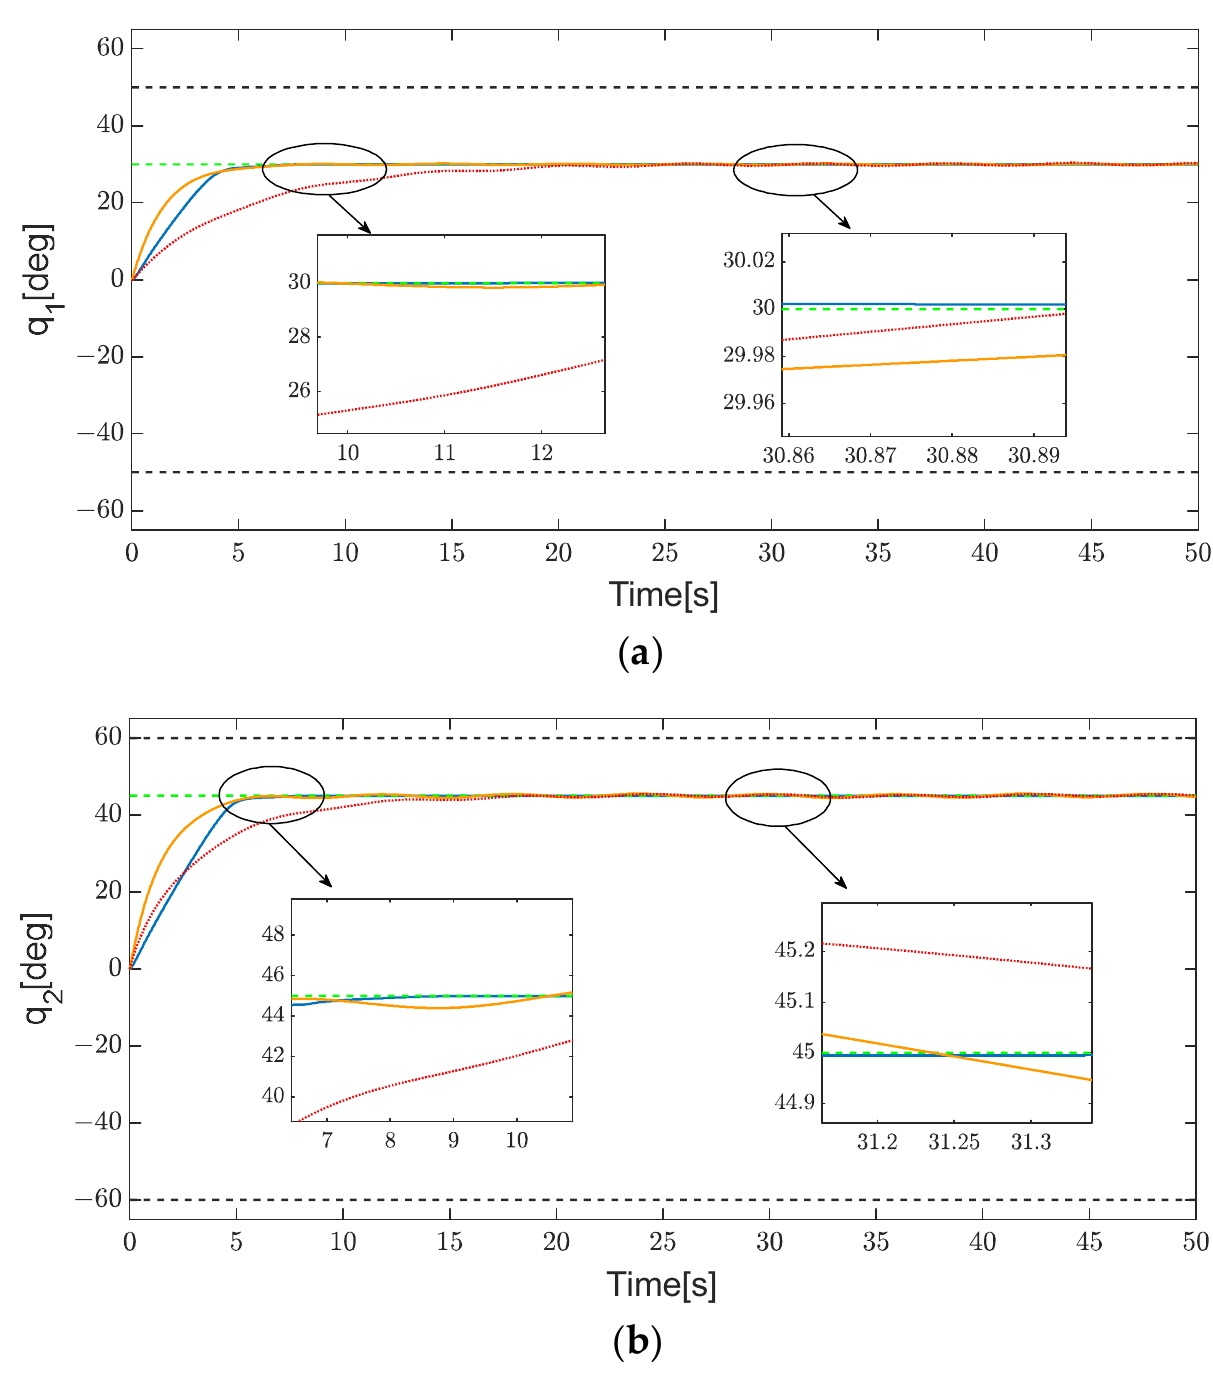
Figure 10. Comparison of angular position to [26,33] in case 2: the [26] scheme (yellow solid line), the [33] scheme (red dash line), the proposed scheme (blue solid line), the reference angular position (green dashed line), the angular position constrains (black dashed line); ( a ) Joint 1. ( b ) Joint 2.